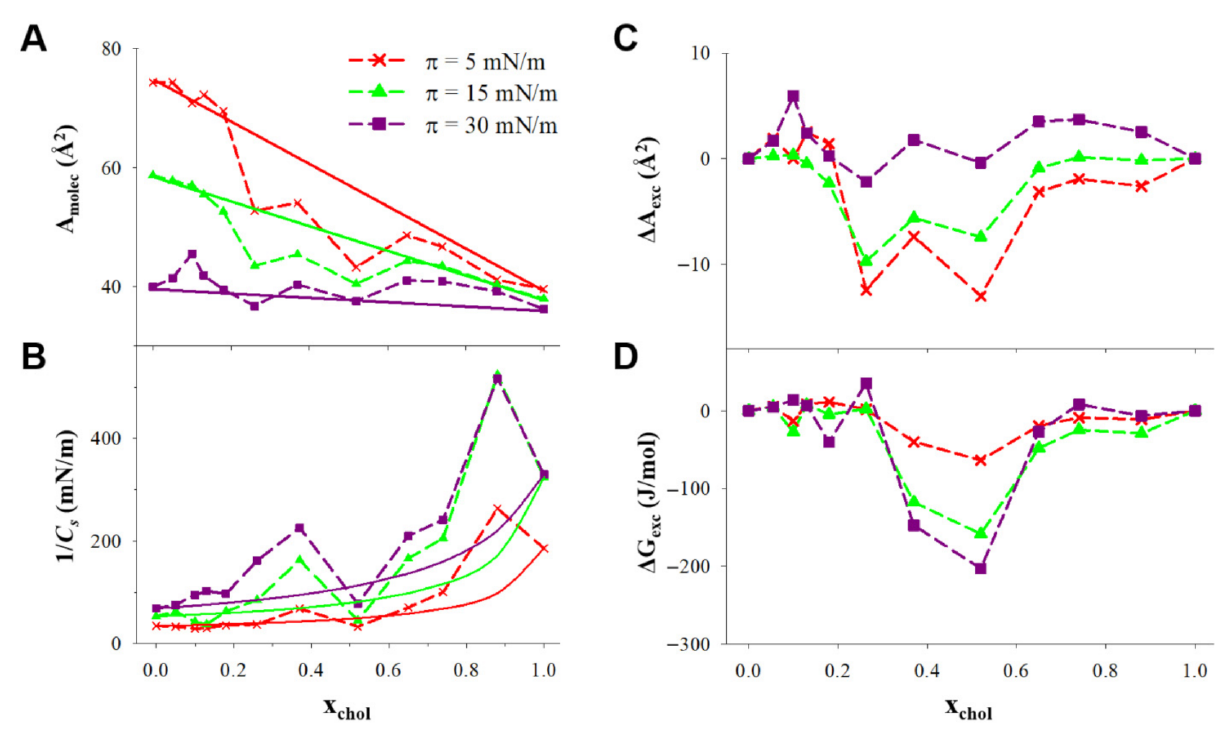
Figure 4. ( A ) Area per molecule and ( B ) compression modulus (1/C s ) plotted vs. the cholesterol mole fraction at the constant pressures indicated in the figure for monolayers of DPPC:DDAB 3:1 and cholesterol. ( C ) Excess area per molecule ( ∆ A exc ), and ( D ) excess free energy ( ∆ G exc ) plotted vs. the cholesterol mole fraction at the constant pressures indicated in the figure for monolayers of DPPC:DDAB 3:1 and